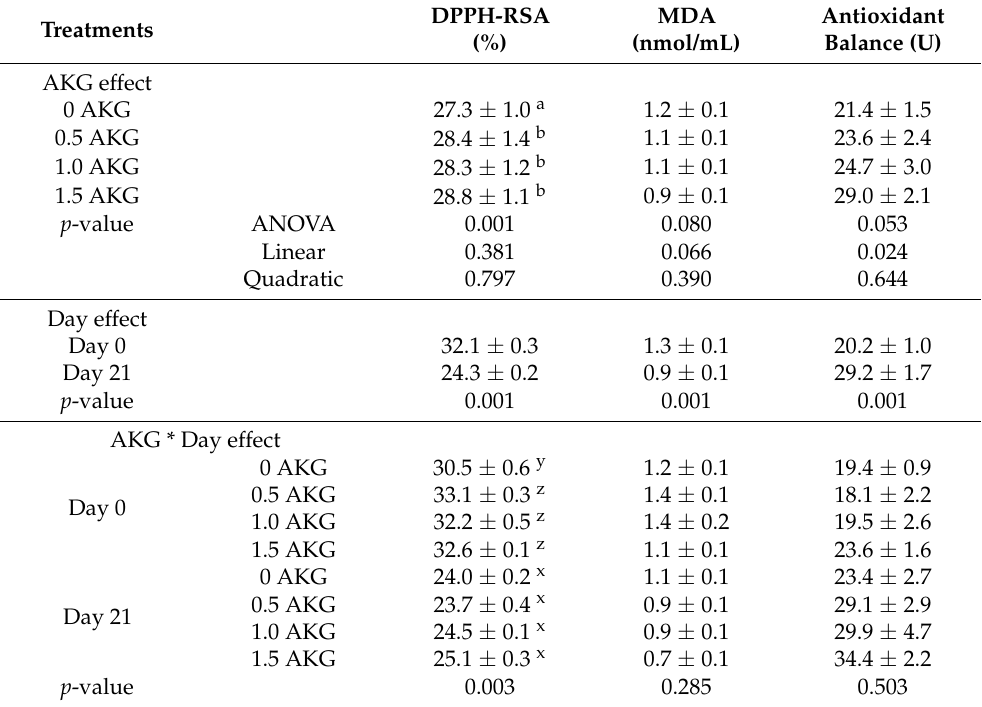
Table 6. Effects of in ovo feeding of α -ketoglutaric acid (AKG) on the plasma antioxidant capacity indicated as DPPH-RSA (%), MDA concentration and antioxidant balance (AB) on day 0 and day 21 of age *.